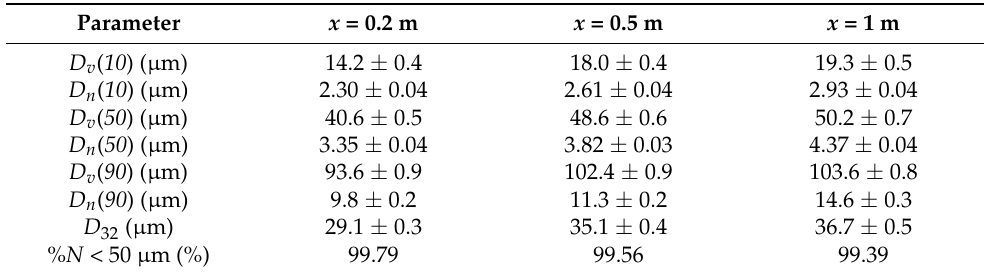
Table 1. The results obtained during the measurements for the F1 plastic filter.